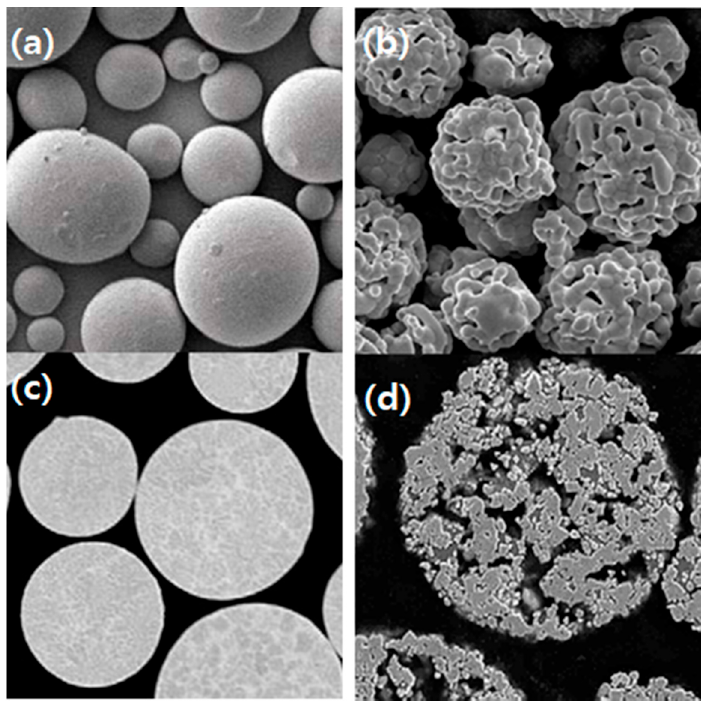
Figure 8. Powder morphology depicted in different manufacturing processes: ( a , b ) External surface; ( c , d ) Cross-section; ( a , c ) Metal alloy powder as gas atomized; ( b , d ) Regular carbide powder as agglomerated and sintered) [91]. (Reused from ref. [91], copyright (2018), Oerlikon Metco). The last factor is moisture adsorbed on the surface. Agglomerated and sintered pow-